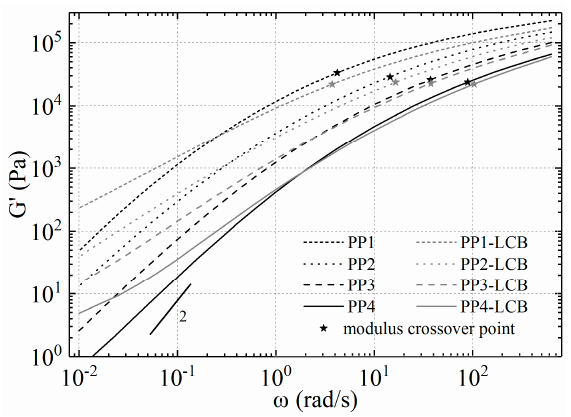
Figure 8. Storage moduli as a function of angular frequency at 180 °C.